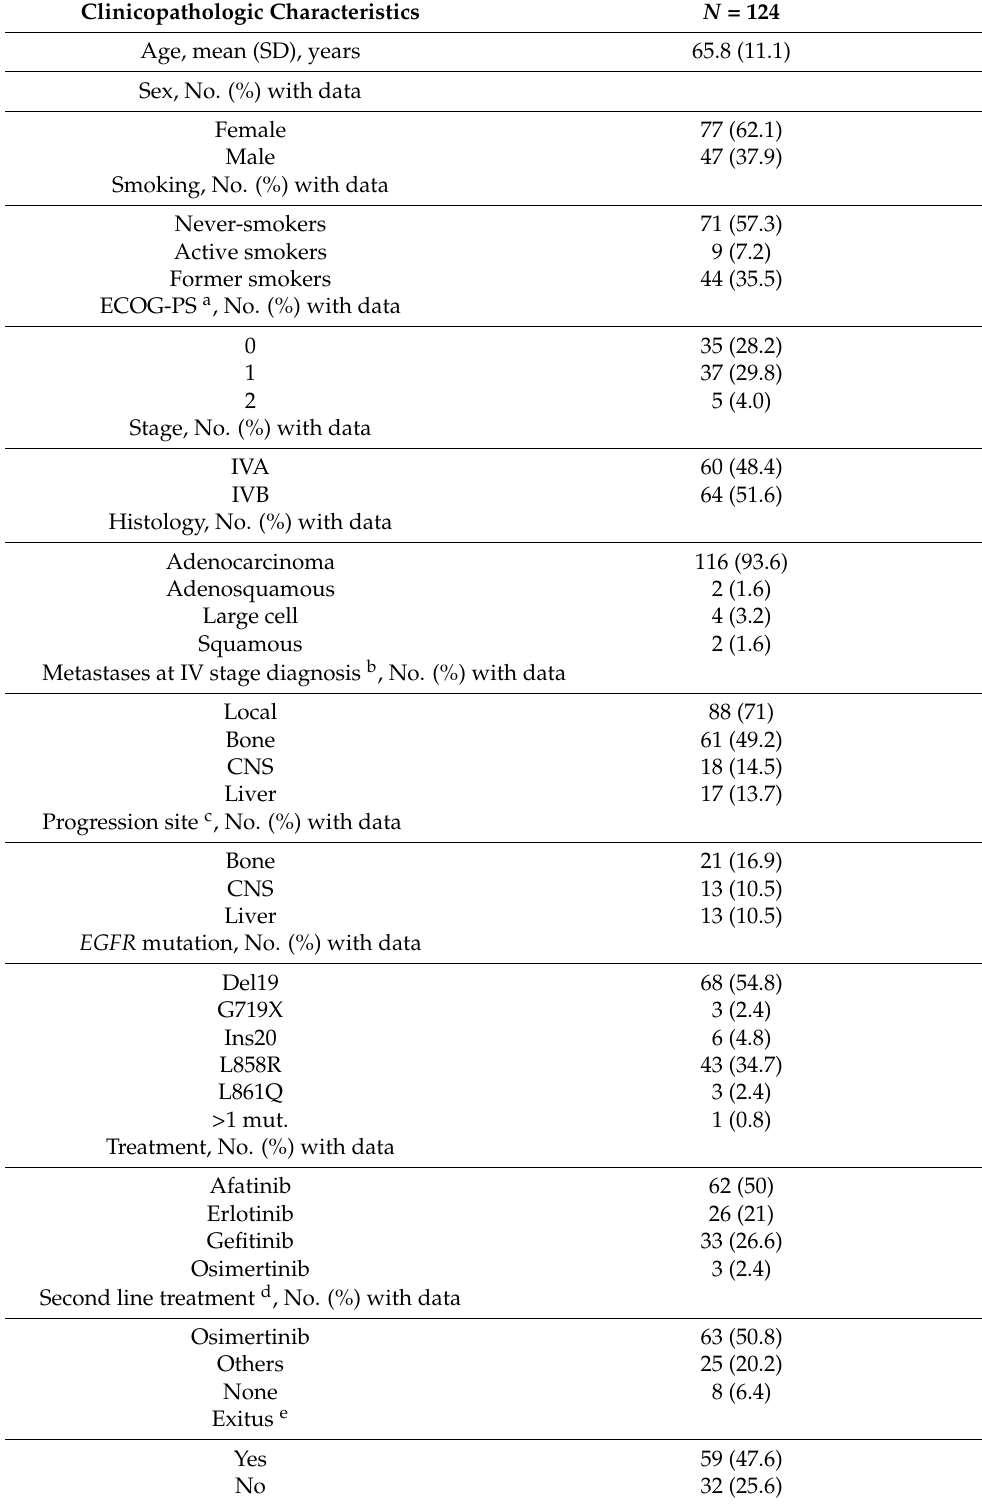
Table 1. Descriptive analysis of the study